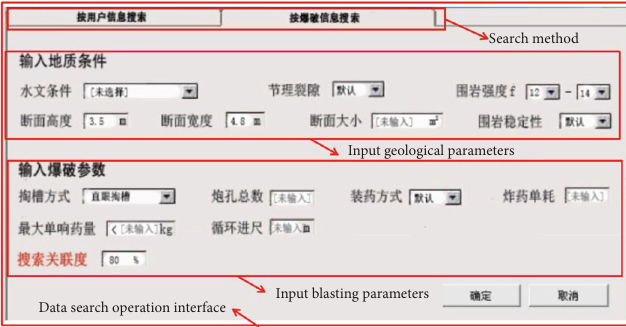
Figure 13: The search interface using intelligent search.